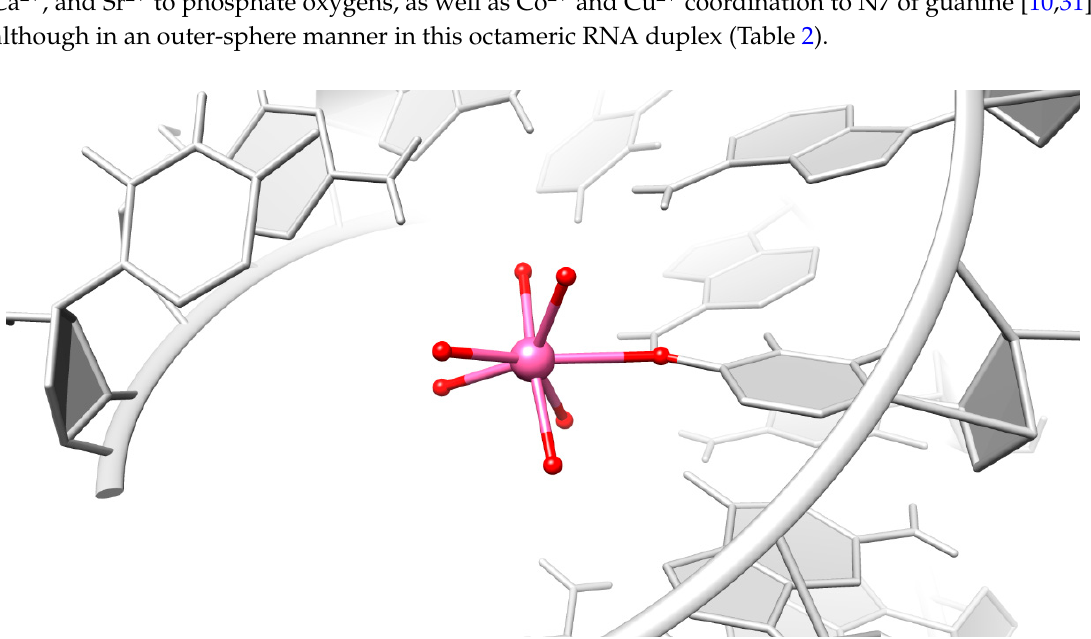
Figure 3. Representative illustration of Ca 2+ (green sphere) connecting the three asymmetric units (in grey, light blue, and pink) by phosphate coordination. Coordinated water molecules are shown in red.